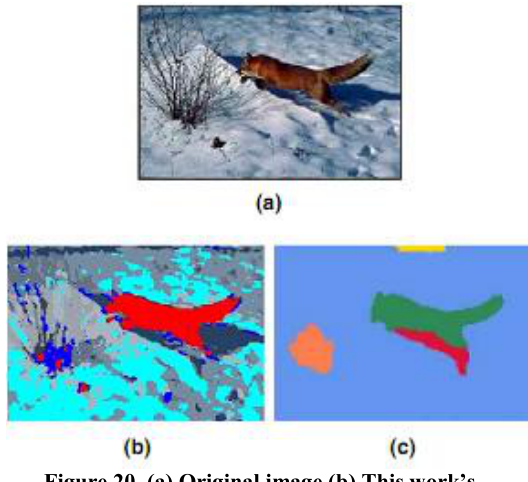
Figure 20. (a) Original image (b) This work’s segmentation (c) Reference 10’s